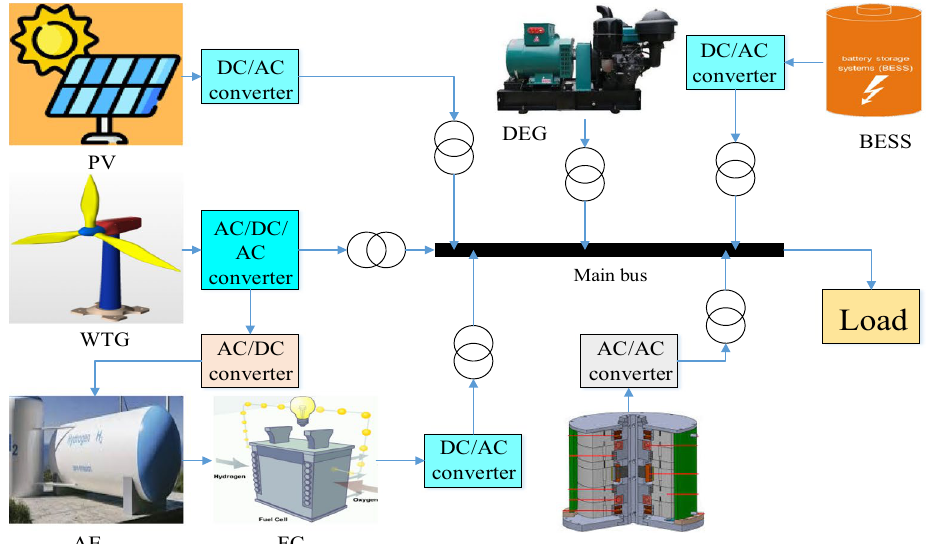
Figure 6. Microgrid under study.